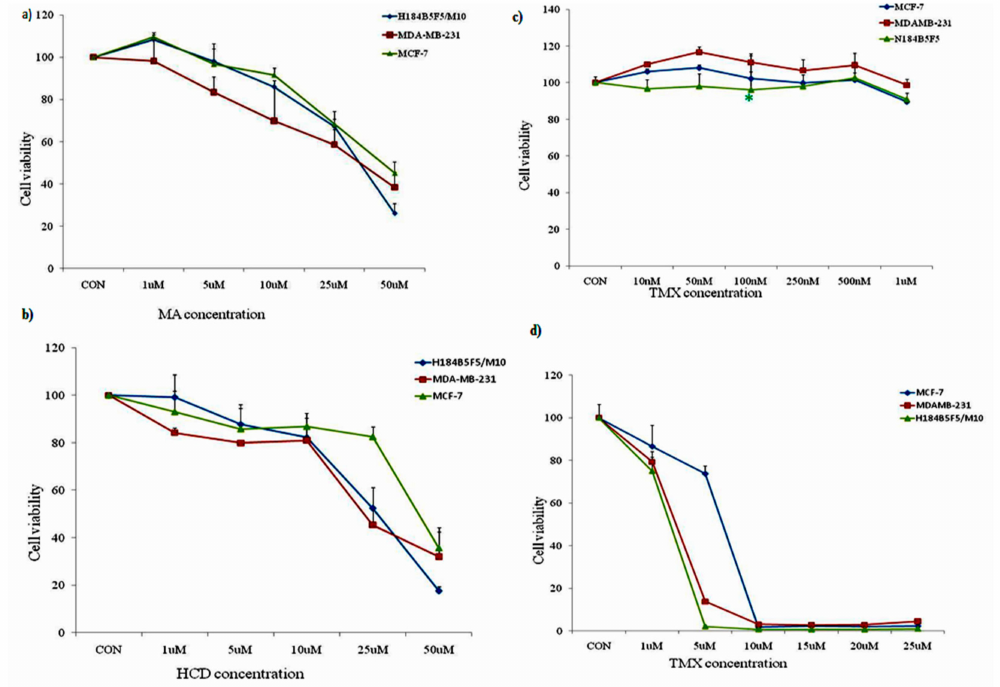
Figure 1. Effect of MA, HCD, and TMX on cell viability of breast cancer cell lines and human mammary epithelial cells by MTT assay. The viability of all the three cell lines was measured after a 24-h treatment with the indicated concentrations of ( a ) MA (1, 5, 10, 25, and 50 µ M); ( b ) HCD (1, 5, 10, 25, and 50 µ M); ( c ) low dose of Tamoxifen (10, 50, 100, 250, 500, and 1000 nM); and ( d ) high dose of Tamoxifen (1, 5, 10, 15, 25, and 25 µ M). Data shown are the mean values ± SE from three independent experiments. Statistical analyses were determined using one-way ANOVA followed by post hoc Tukey multiple comparison test with ** p < 0.01, *** p < 0.001, significantly different from control. Tamoxifen (TMX) was then used to test the concentration of breast cancer cells (MCF-7 and MDA-MB-231) and human mammary epithelial cells (H184B5F5/M10) in order to facilitate